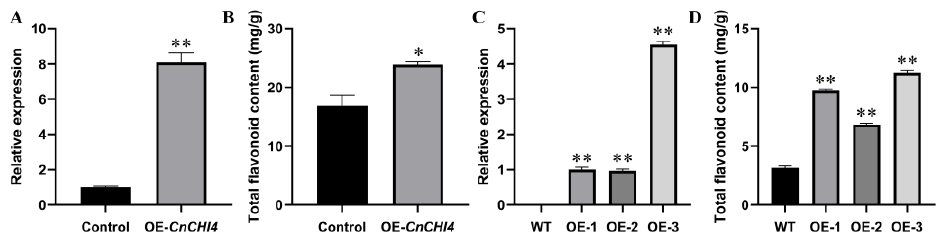
Figure 6. Overexpression of CnCHI4 in C. nitidissma and N. tabacum . ( A ) Relative expression levels of CnCHI4 in the control (empty vector) and experimental (pCAMBIA1302-CnCHI4) groups in C. nitidissma leaves after transiently transformed. ( B ) TFC in the control and experimental groups in C. nitidissma leaves after transiently transformed. ( C ) Relative expression levels of CnCHI4 in the wild-type tobacco plants and plants overexpressing CnCHI4 . ( D ) TFC in the wild-type tobacco plants and plants overexpressing CnCHI4 . The error bars indicate the SE from three replicates; statistical significance was determined using Student’s t -test (* p < 0.05; ** p < 0.01). WT, wild-type, OE, overexpression.